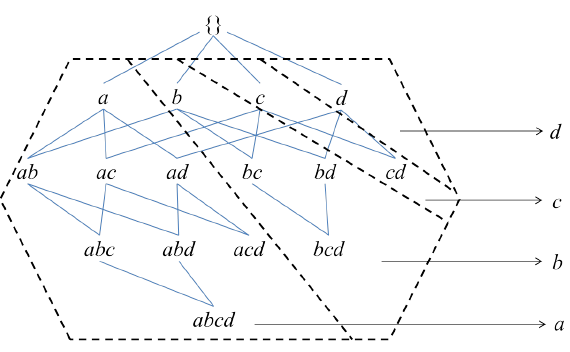
Figure 4. Depth-first search.